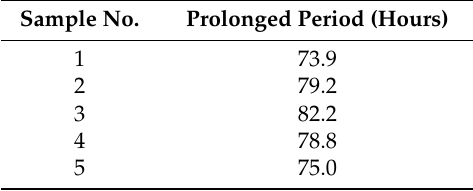
Table 2. Pre-experimental verification of prolonged period (hours) for the reference